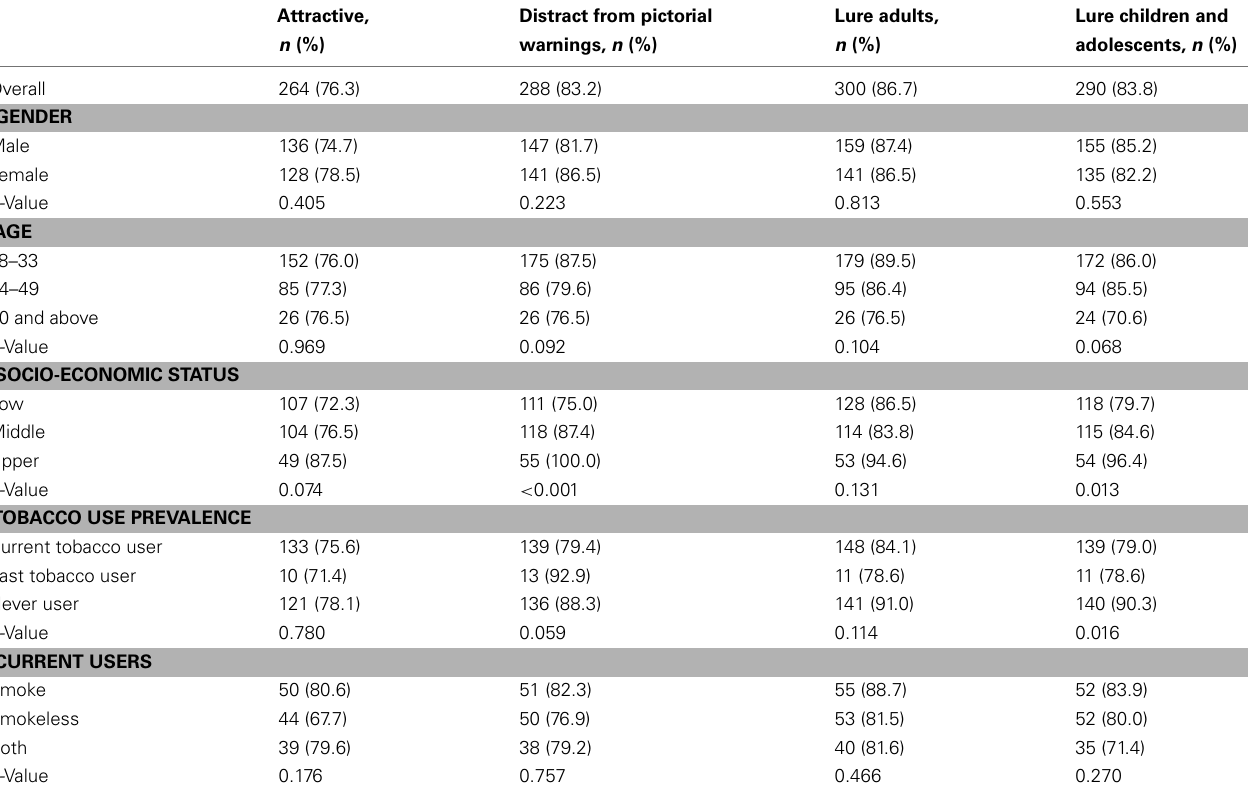
Table 2 | Perceptions about current tobacco packs on overall look and attractiveness, by demographic profile and tobacco use status of the